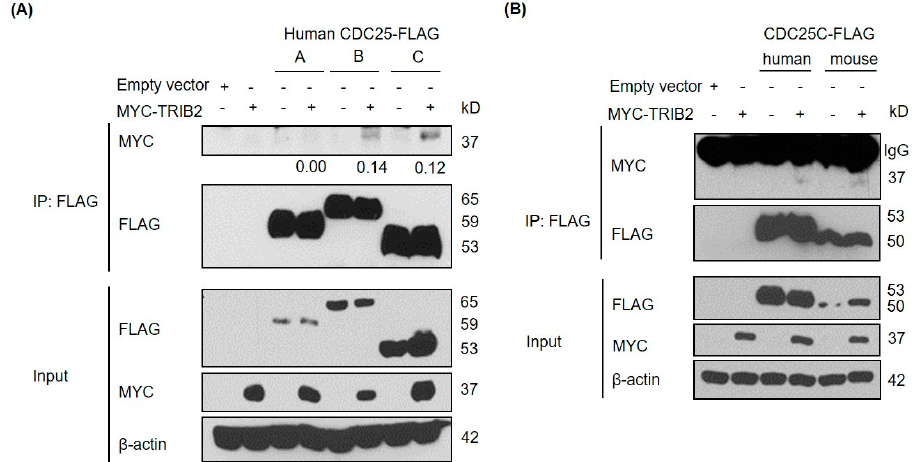
Figure 1. Tribbles homolog 2 (TRIB2) interacts with isoform B and C of cell division cycle 25 (CDC25) family proteins physically. ( A ) Interaction of MYC-tagged TRIB2 with different isoforms of FLAG-tagged CDC25 proteins was examined by co-immunoprecipitation (co-IP) in HeLa cells. IP, immunoprecipitation. Co-immunoprecipitated MYC-tagged TRIB2 signals were quantified by densitometry analyses and normalized to the respective immunoprecipitated FLAG-tagged CDC25 signals. The normalized values are indicated below the sub-panel; ( B ) interaction of MYC-tagged TRIB2 with human and mouse orthologues of FLAG-tagged CDC25C was examined by co-IP.